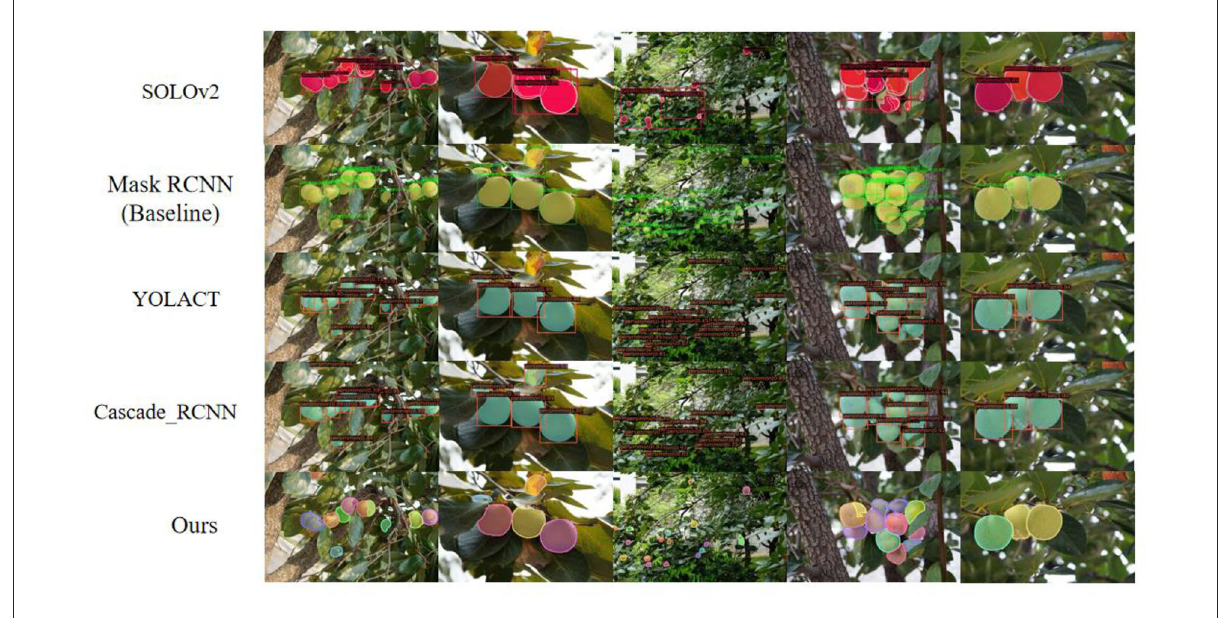
FIGURE9 Comparison of segmentation effects of five different models.